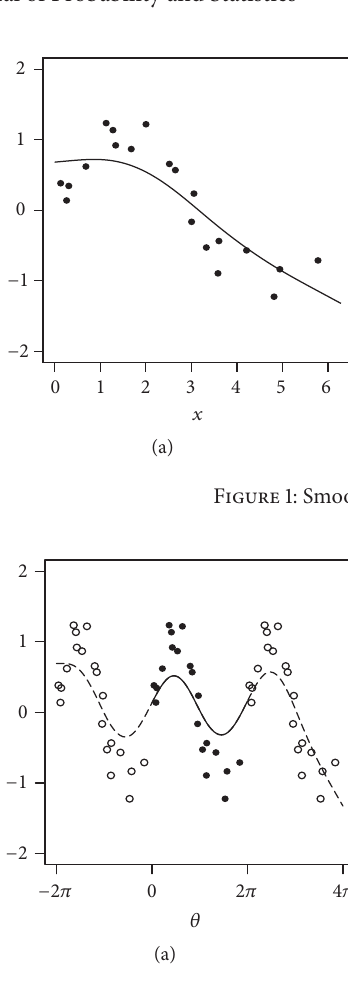
Figure 2: Periodic spline fits to sin data: (a) Df = 7 ; (b) Df CV = 15 ; (c) Df = 30